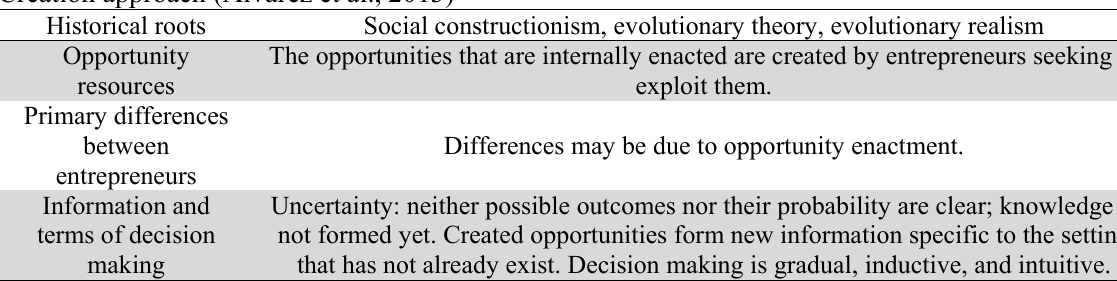
Creation approach (Alvarez et al.,